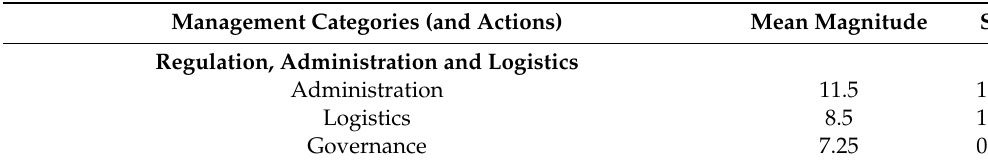
Figure 1. Mean magnitude scores (and standard deviations) for the management actions selected. Table 2. Mean magnitude score for the management actions (and categories, in bold) selected for the case study (Torre Flavia wetland nature